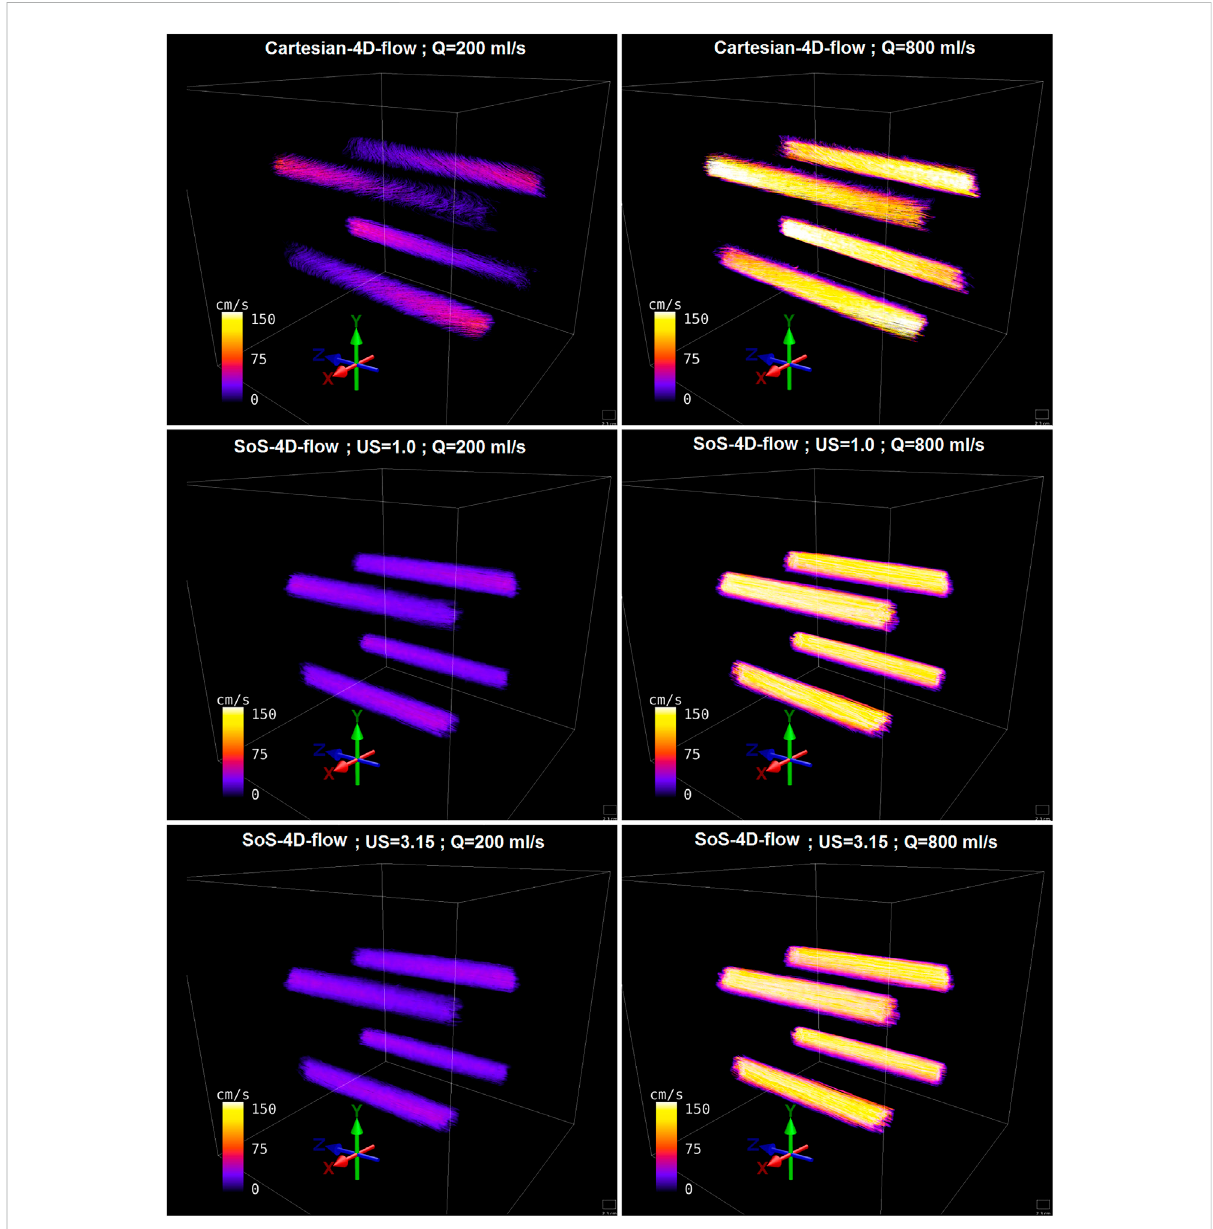
FIGURE 5 Representative streamline visualization of the in-vitro fl owing water phantom reconstructed from fully-sampled SoS-4D- fl ow, undersampled SoS-4D- fl ow (by a factor of π ), and Cartesian-4D- fl ow data at high and low pump speeds (Q